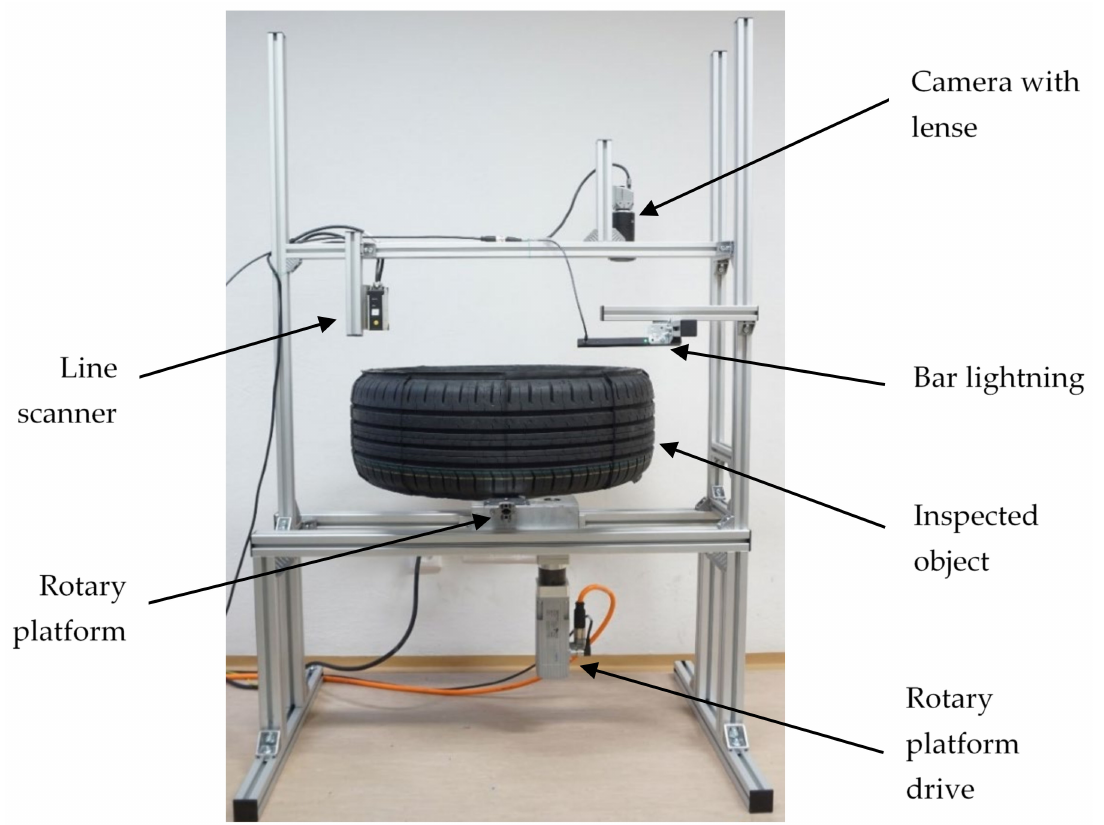
Figure 10. Testing rig with rotary